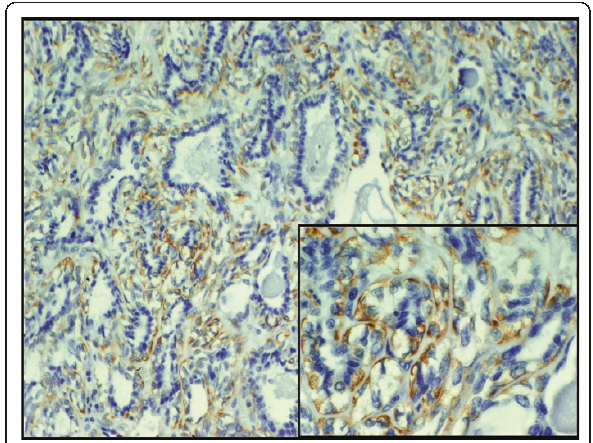
Figure 5 The myoepithelial component is positive for p27/kip- 1 (cytoplasmic positivity)